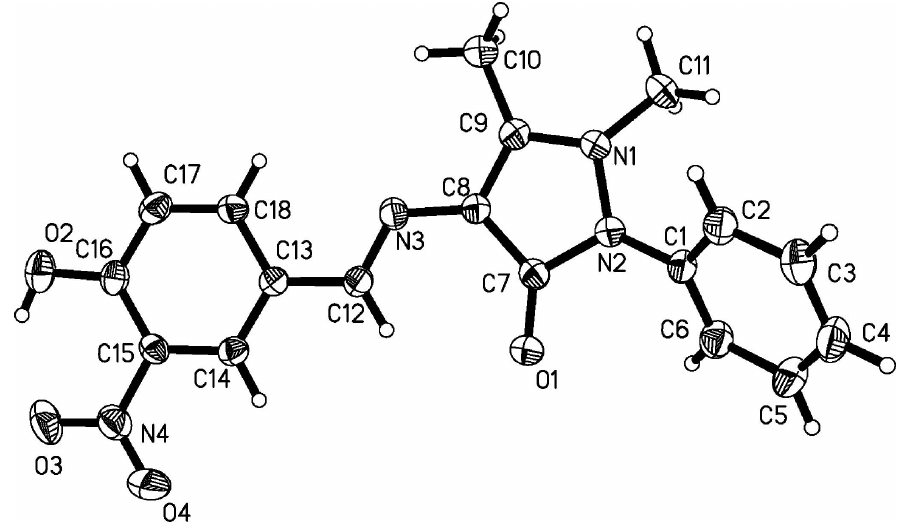
Figure 1 The structure of (I): non-H atoms are shown as 50% probability displacement ellipsoids.